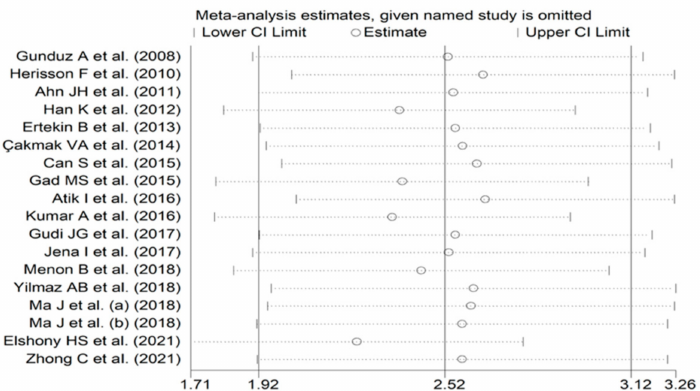
Figure 3. Sensitivity analysis of the association between ischaemia-modified albumin and acute ischaemic stroke. For each study, the effect size (hollow circles) corresponds to an overall effect derived from a meta-analysis excluding that study.